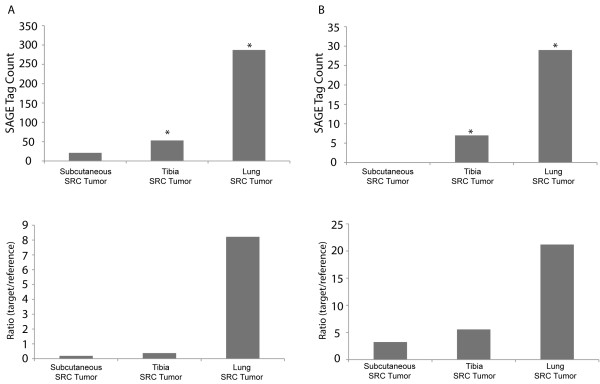
SAGE and quantitative RT-PCR confirm the expression of thymosin-β4 and c-fos in the SRC tumors. (A) Thymosin-β4 expression in the SRC tumors (SAGE analysis top panel; quantitative RT-PCR bottom panel). (B) C-fos expression in the SRC tumors (SAGE analysis top panel; quantitative RT-PCR bottom panel). SAGE and RT-PCR identified similar gene expression patterns for both thymosin-β4 and c-fos. Note the increased expression of thymosin-β4 and c-fos in the tibia and lung SRC tumors. The graphical bars in the RT-PCR figure represent the average expression ratio calculated on RNA that was collected from pooled tumor tissue. For RT-PCR at each transplantation site, tissue was pooled from at least 10 separate tumors. SAGE data was normalized to 100,000 tags/library for analysis. In the SAGE graph, "*" indicates that the expression levels of a specific sample are significantly different relative to the "Subcutaneous SRC tumor" sample (z > 1.96).